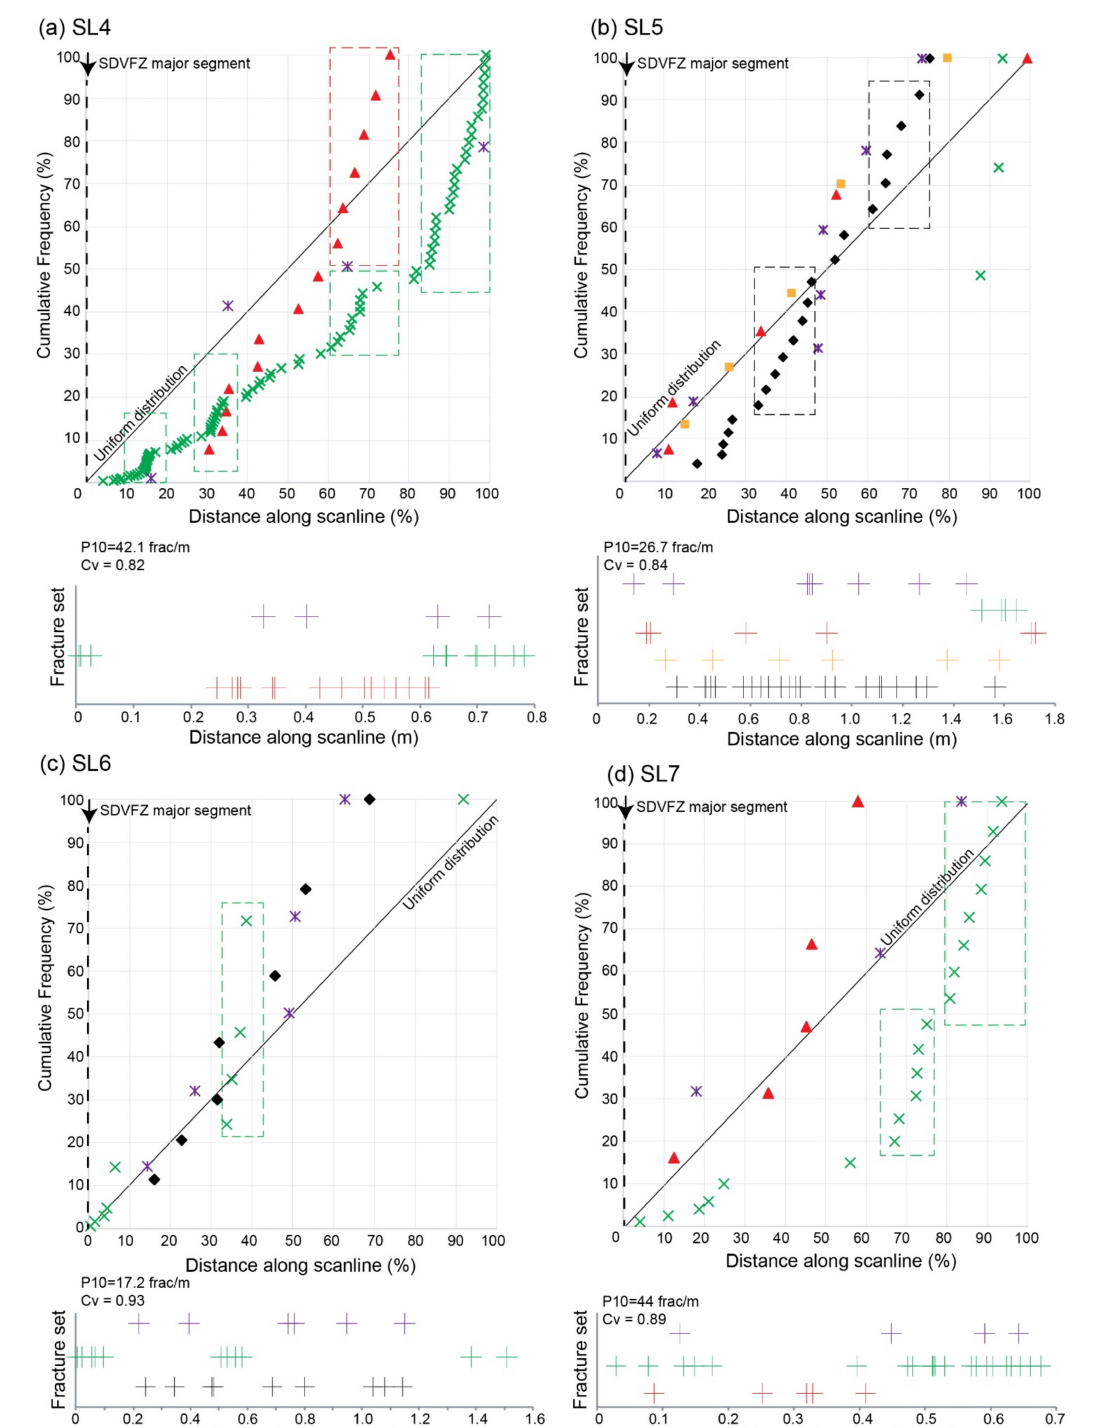
Figure 8. Cumulative frequency diagram along each scanline and following each fracture set (in colors). Plot of cumulative frequency expressed in % versus distance along scanline for: ( a ) SL4, ( b ) SL5, ( c ) SL6, and ( d ) SL6. Dashed lines indicate a potential cluster for each fracture distribution, indicating a rapid increase in the number of fractures with slope threshold > 2. The diagonal line in each plot of cumulative frequency defines a uniform or regular distribution. Visual location of fractures expressed in stick plots for each fracture set distribution, indicating the fracture position along the scanline, including the fracture density (P 10 ) and the coefficient of variation (Cv) values. The structural position is done in each diagram. See the color legend in Figure